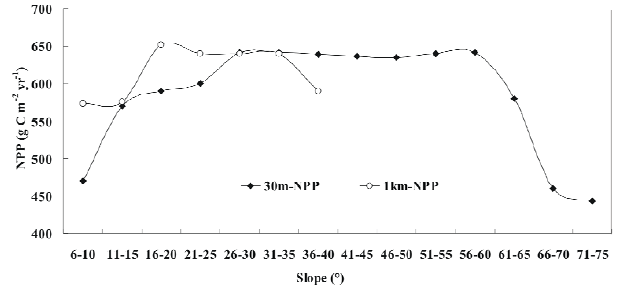
Fig. 15. NPP variation with slope at 30m and 1km resolutions. The range of slope at 1km resolution is plotted at the same scale as that at 30m, but is much smaller because of the averaging process.